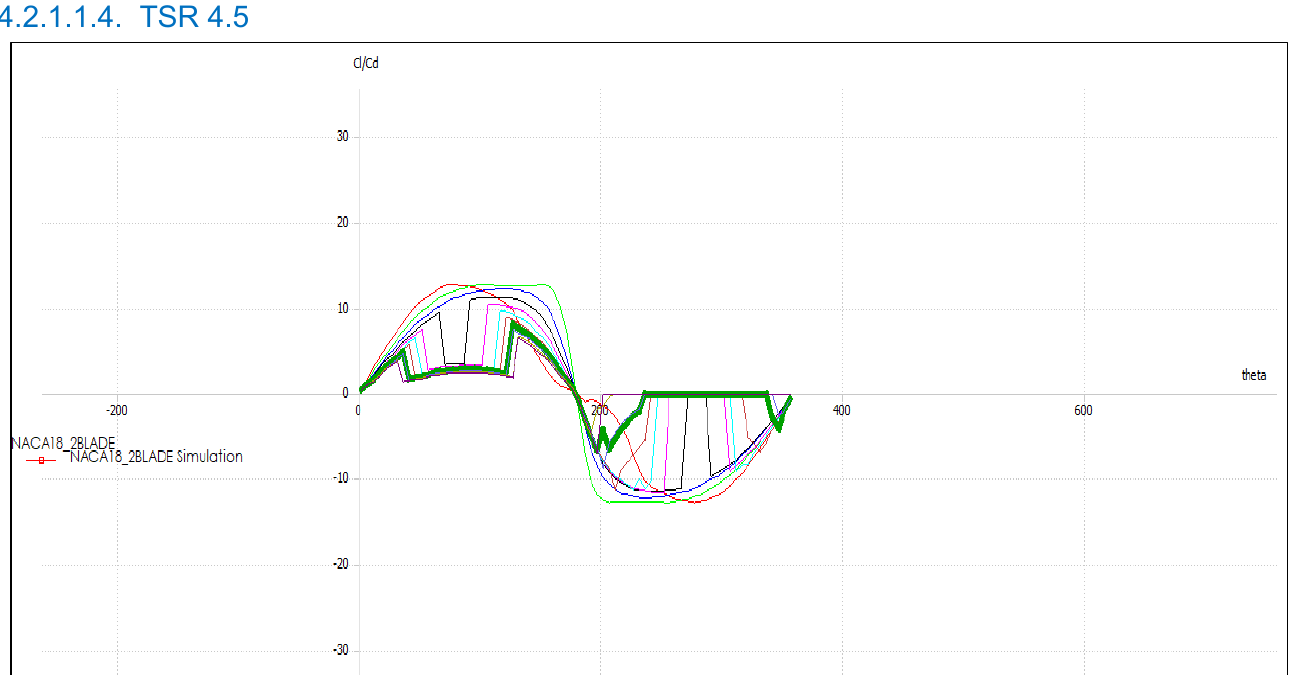
Figure 14. Cl/Cd vs theta plot of top-section for TSR 4.5